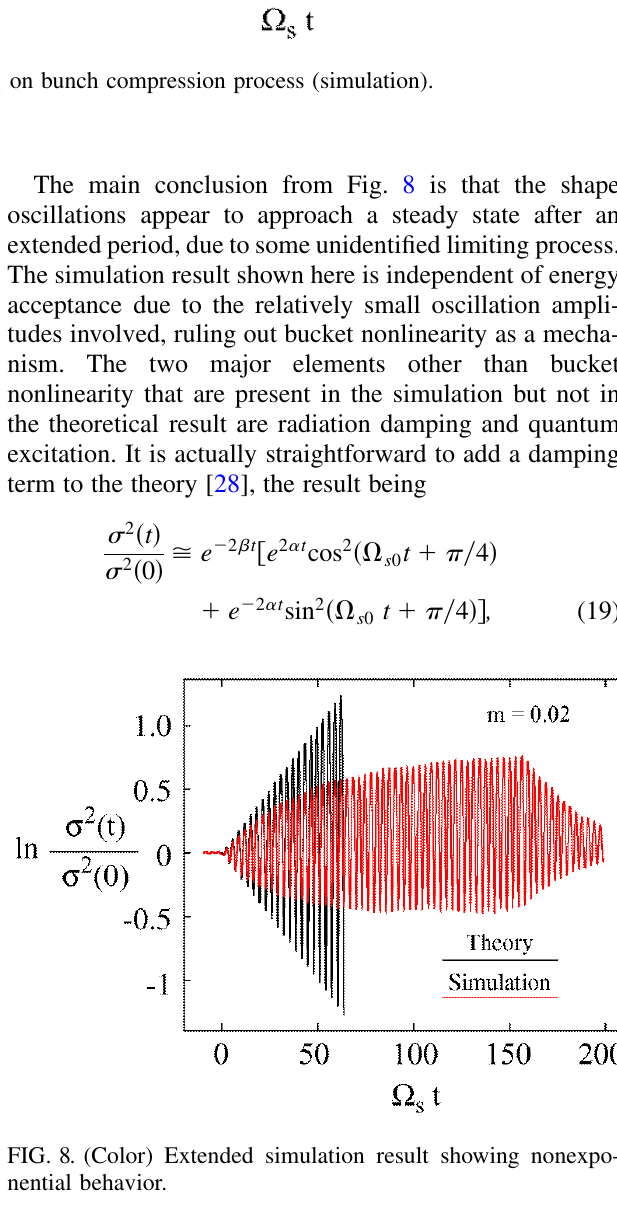
FIG. 7. (Color) Effect of energy acceptance "